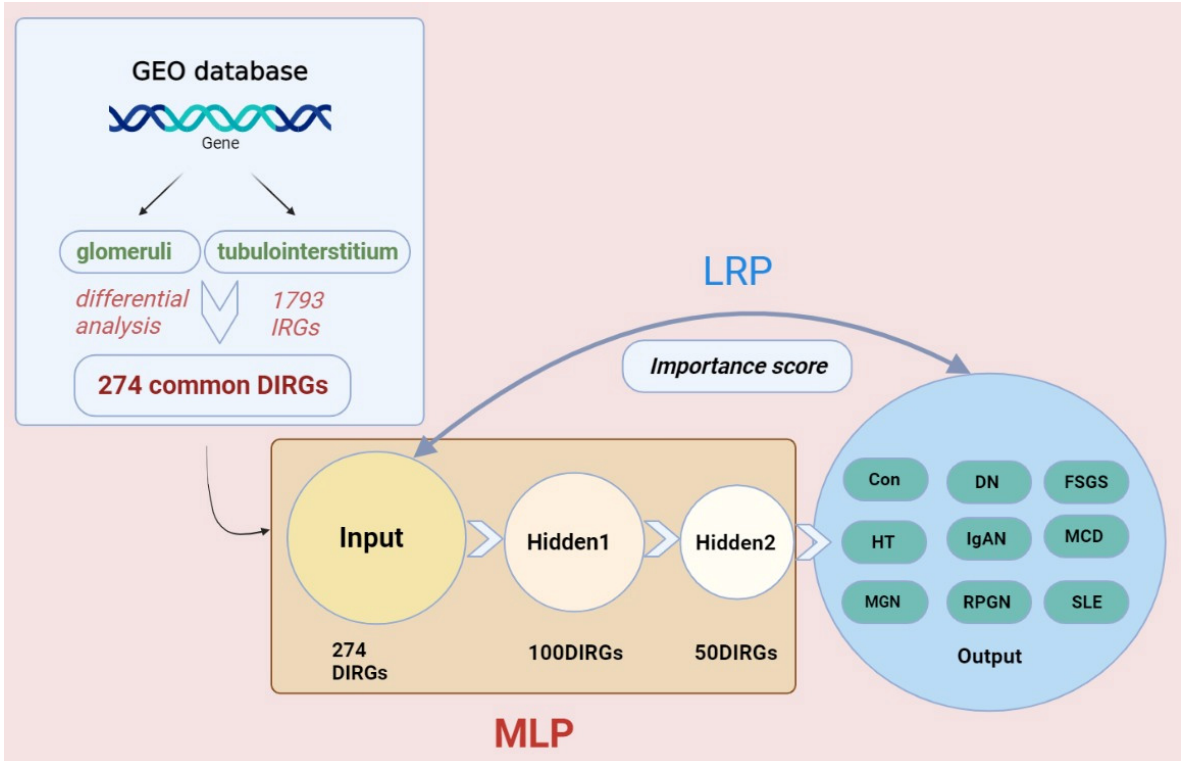
Figure 7. Workflow of the deep learning. Firstly, we downloaded microarray data from GEO database, screened candidate genes, and constructed MLP network. Then, LRP algorithm was used to calculate the characteristic genes of each GN subtypes. Table 3. The top five characteristic genes of eight GN subtypes.